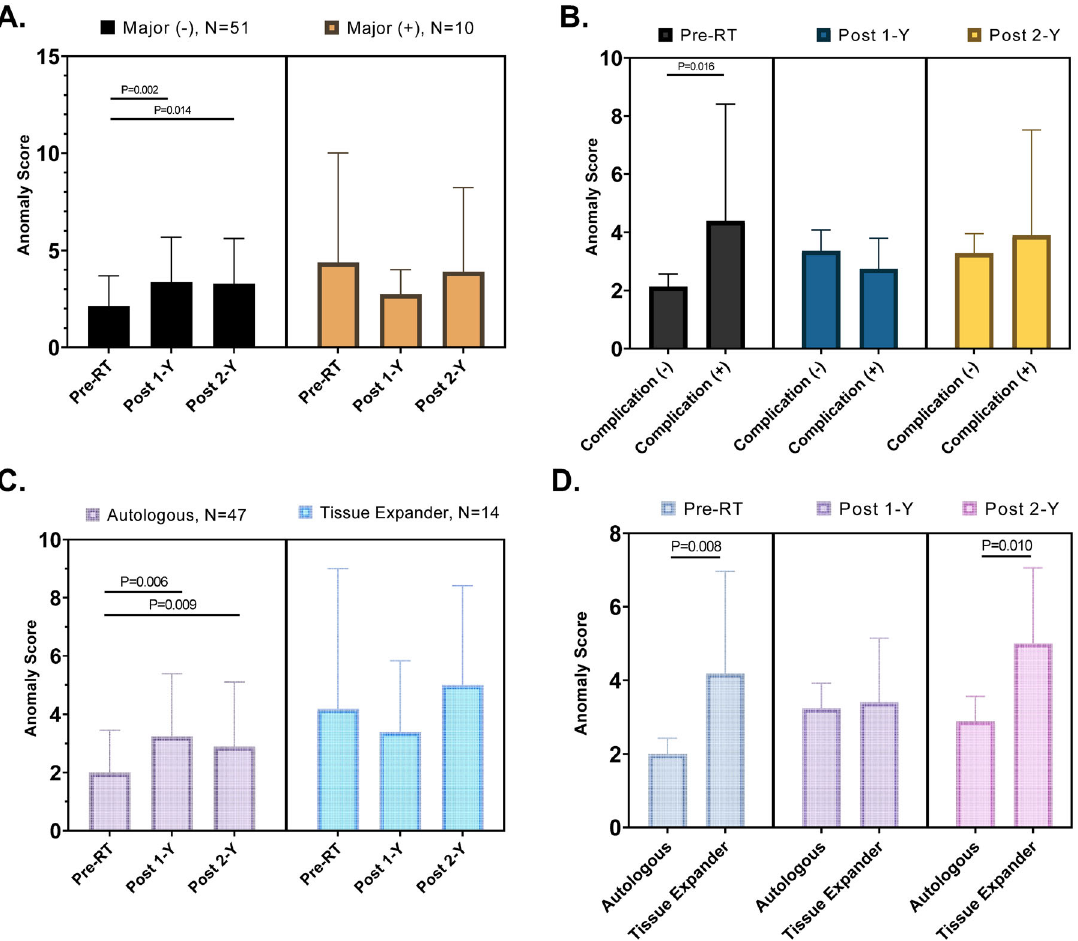
Fig. 3 Comparative analyses using anomaly score. A Comparison of anomaly score among Pre-RT, Post-1Y, and Post-2Y time points, strati fi ed by major complication event. B In each time point, anomaly score is compared according to complication event. C Strati fi ed by reconstruction type, anomaly scores according to three time points are compared. D In each time point, anomaly score from patients with autologous tissue and tissue expander is compared. P -value was estimated by pairwise paired T -test. P -value was estimated by pairwise paired T-test. The 95% con fi dence intervals are drawn as error bars at each point. RT Radiation therapy, 1-Y 1 year, 2-Y 2